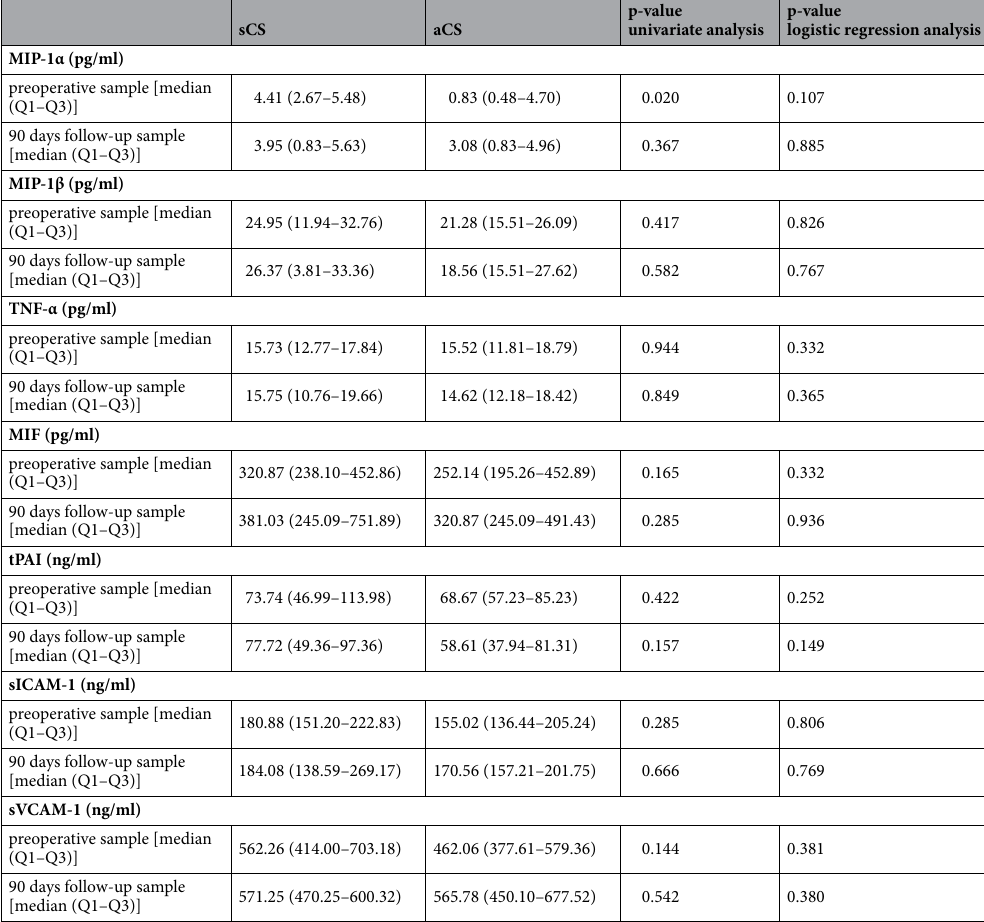
Table 2. Comparison of biomarker concentrations in patients with symptomatic and asymptomatic carotid stenosis. P-values were calculated using Student’s t test or Mann–Whitney U test as appropriate and binary logistic regression analysis adjusted for grade of stenosis, ESRS antithrombotic pre-treatment and statin pre- treatment, aCS asymptomatic carotid artery stenosis, Q1–Q3 quartile 1–quartile 3, sCS symptomatic carotid artery